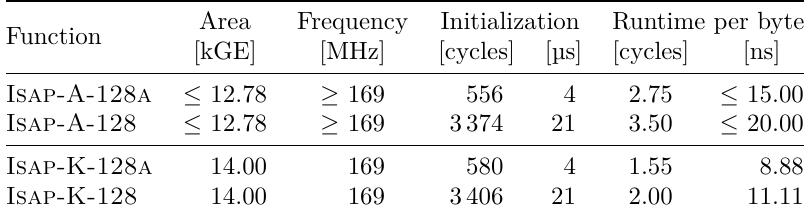
Table 5: Hardware characteristics of all Isap